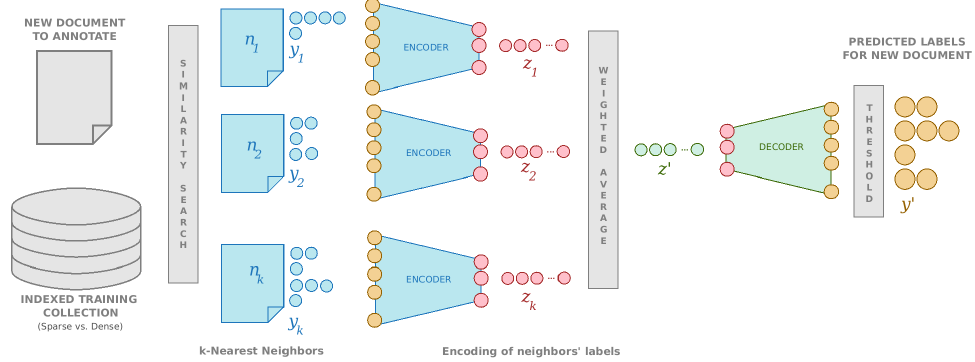
Figure 2. Categorization using k -NN with label